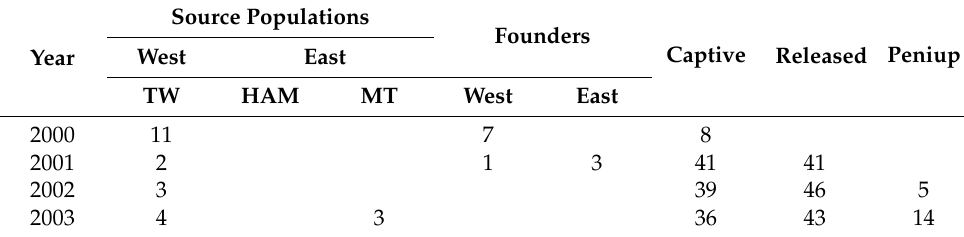
Table 1. Summary of Parantechinus apicalis samples used in this study. Eastern and western sources represent the following source populations and locations where wild-born animals were trapped: Hamersley Moir (HAM), Moir Track (MT) and Twertup (TW). Founders are individuals selected from the source populations to breed in the captive colony at Perth Zoo. ‘Captive’ represents animals born in captivity between 2000 and 2010. ‘Released’ represents animals that were released to the Peniup Nature Reserve between 2001 and 2010. This includes both captive and wild-born animals. Peniup represents wild-born animals caught at the reintroduction